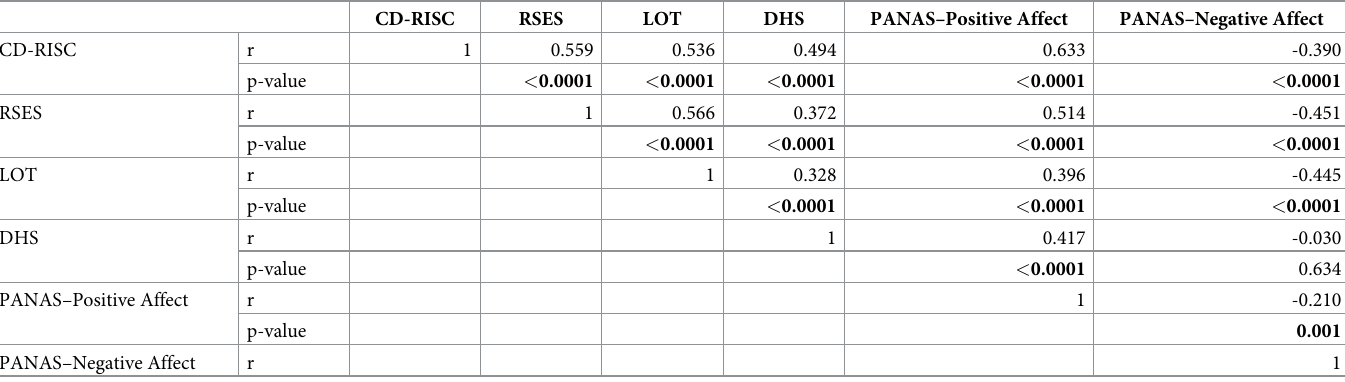
Table 2. The Pearson correlation coefficients between Arabic CD-RISC with the other studied